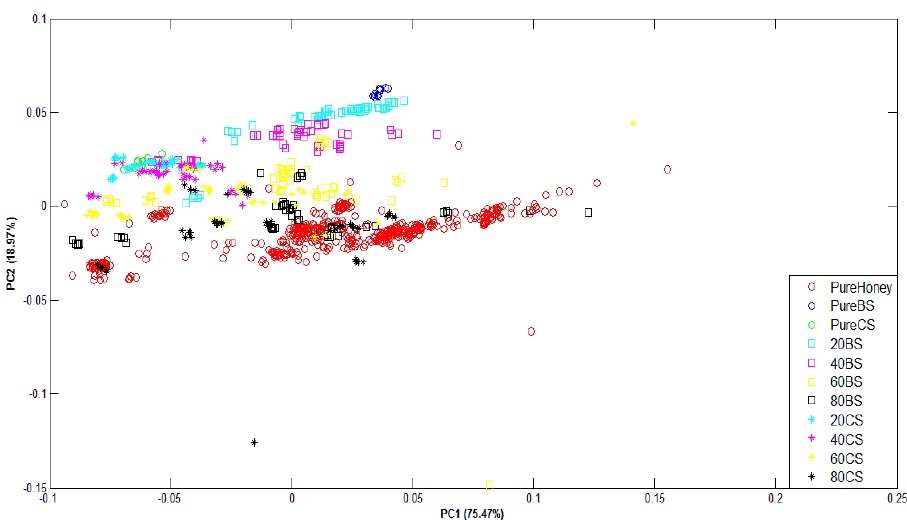
Figure 8. PCA plot of normalized FTIR